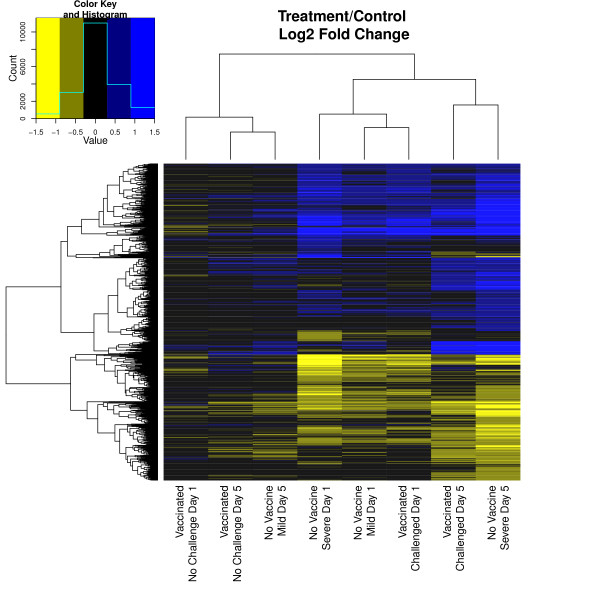
Heatmap comparison of treatments and controls. Visual representation of log2 fold change differences between all treatment groups and day appropriate NV-NC control. Genes included were significant in at least one contrast presented (q-value < 0.05). Positive fold change indicates greater expression in treatment group.